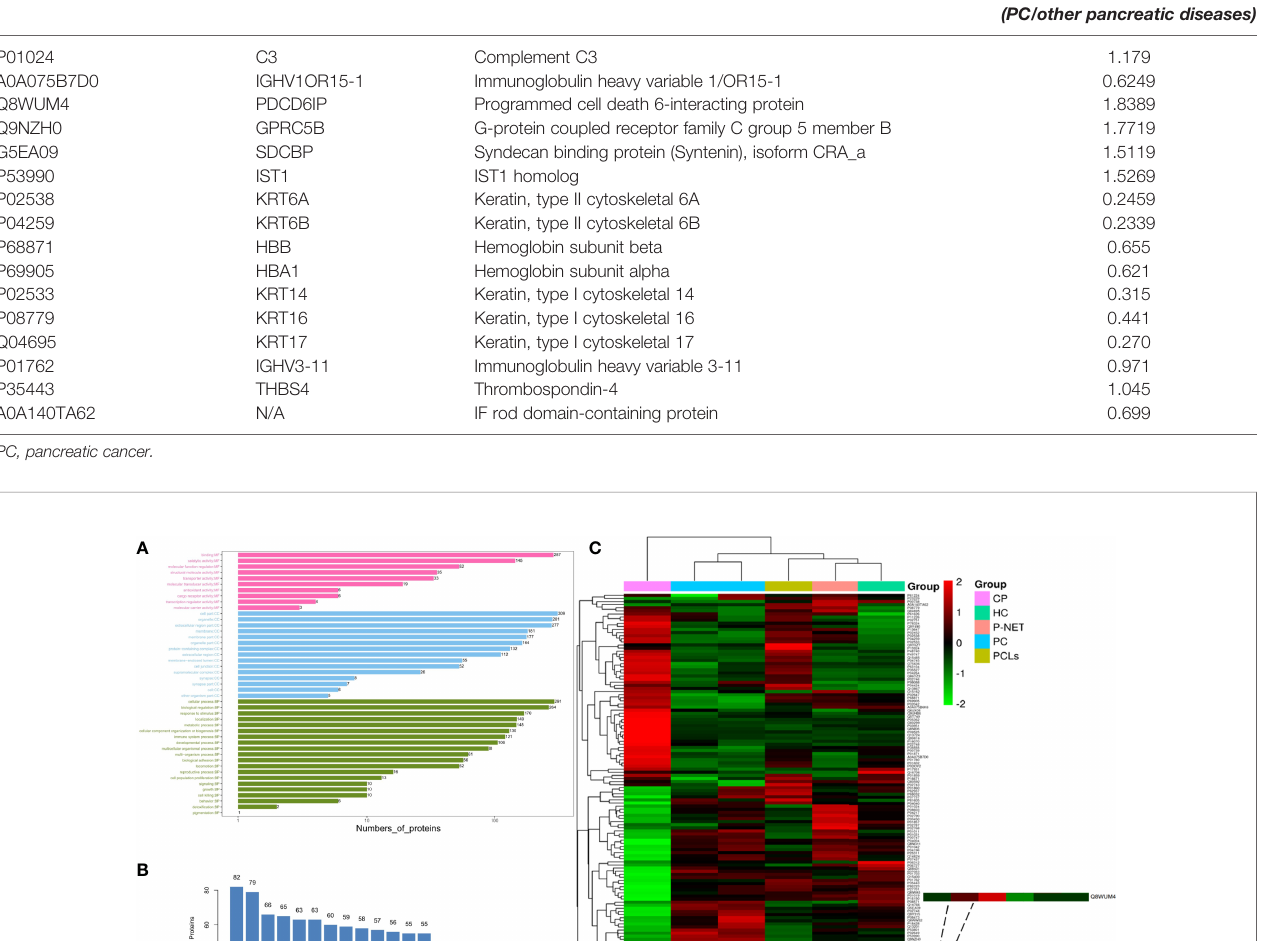
(PC / other pancreatic diseases)